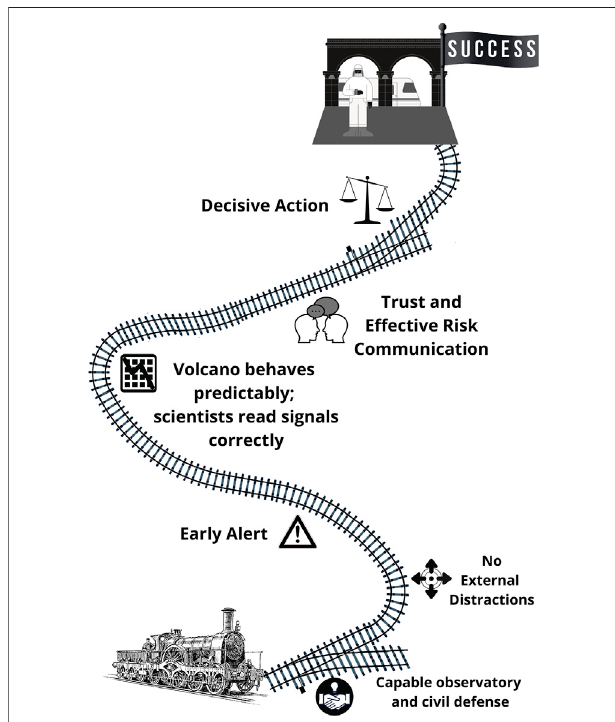
FIGURE 1 | Metaphorical path of train to successful risk mitigation, without getting derailed or shunted to siding along the way. Details of the various waystations in the Pinatubo case are given in the